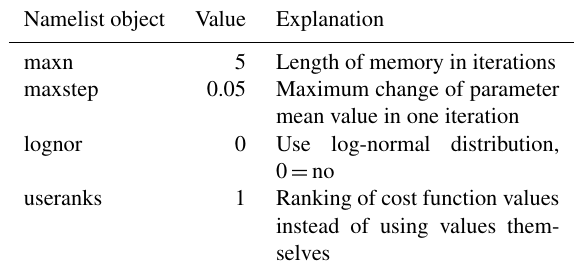
Table A2. Other settings of EPPES.